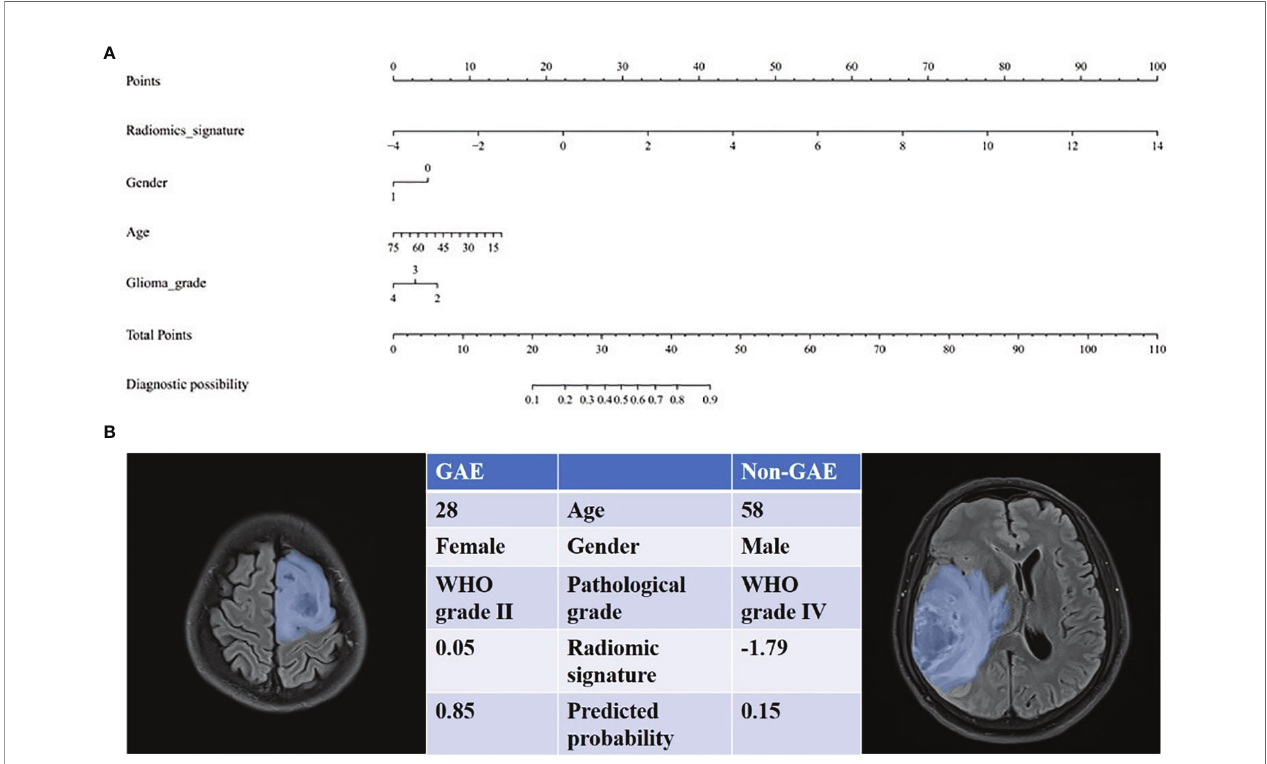
FIGURE 5 | The radiomics nomogram for prediction of epilepsy type. (A) The radiomic-based nomogram was built using radiomics signature, age, gender (0 = male, 1= female), and tumor grade data. (B) Two cases for which the diagnostic probability of GAE was